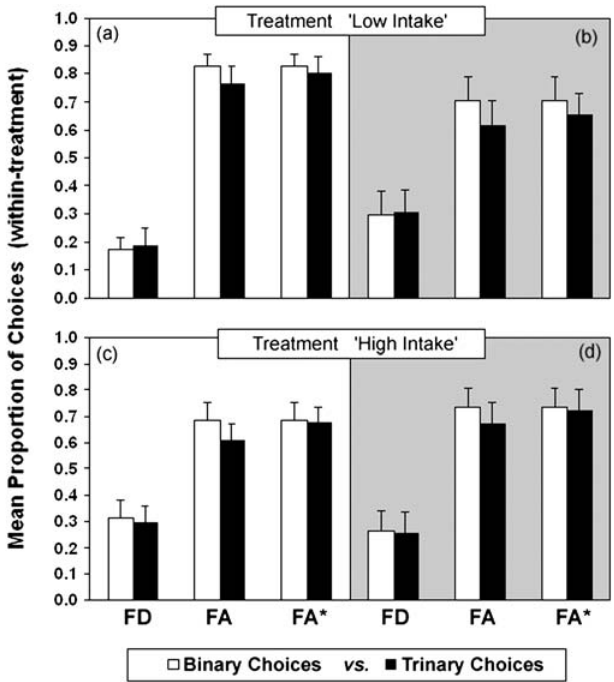
Figure 5. Within-Treatments Comparison of Binary and Trinary Choice Trials The bars show the mean ( 6 s.e.) absolute (FD and FA) and relative (FA*) proportion of choices for each option in the binary (white bars) and trinary (black bars) trials for group NC (A and C) or group C (B and D). Relative preferences were calculated using equation 1 (see text). We compared the preference for the same options between the binary and trinary contexts of the same treatment (when there are no differential energetic effects). There were no violations of either regularity or the constant-ratio rule ( p . 0.1). DOI: